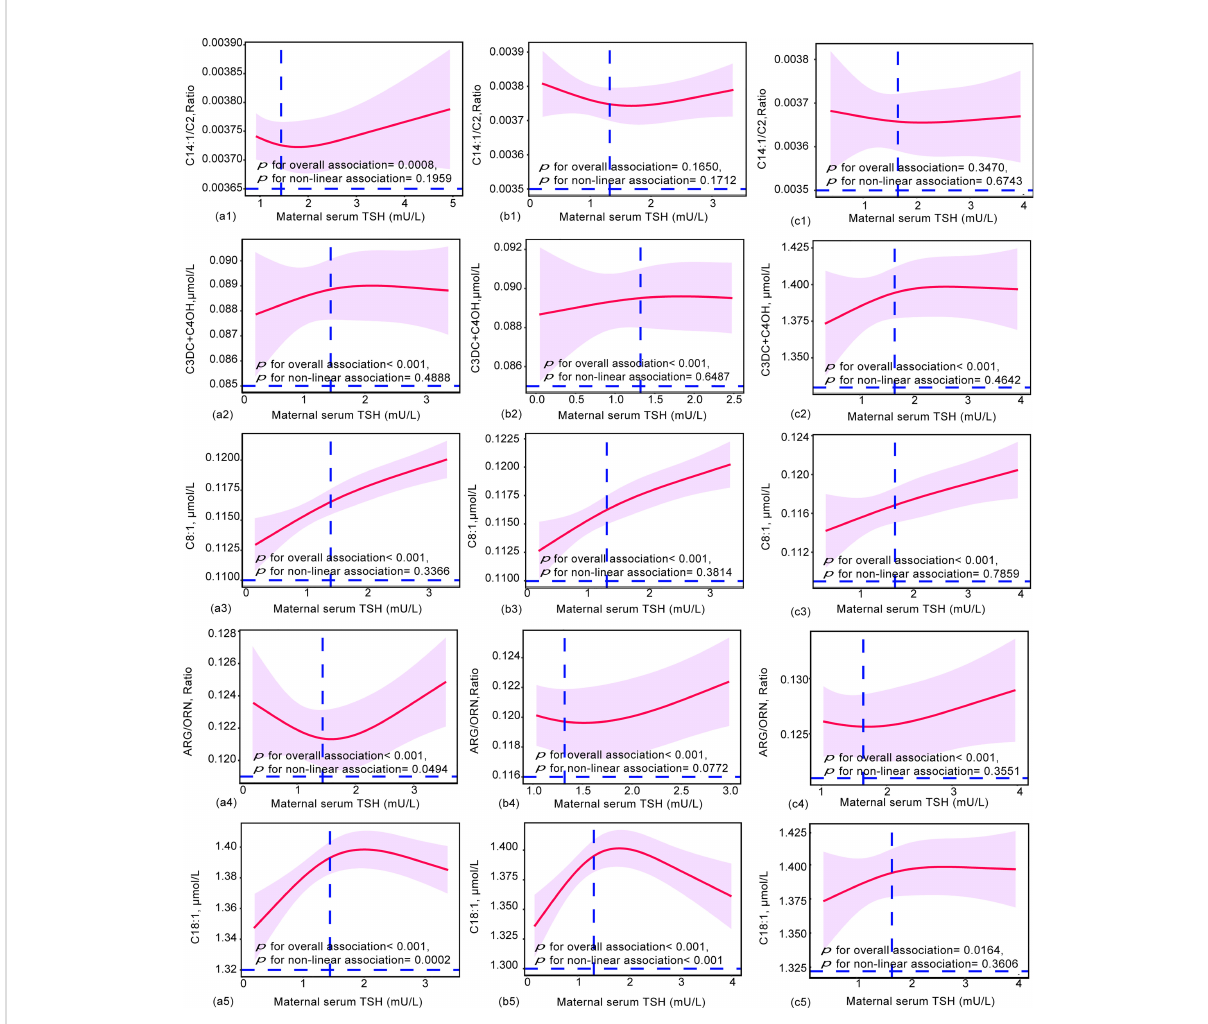
FIGURE 3 Restricted cubic spline (RCS) regression analysis for the maternal TSH and neonatal metabolites during (a) ( 1-5) overall pregnancy, (b) ( 1-5) at the fi rst trimester, or (c) (1-5) at the second and third trimesters. Neonatal metabolites included were selected by GLM models. The median concentrations of maternal TSH were 1.44 mU/L during overall pregnancy, 1.32 mU/L at the fi rst trimester and 1.65 mU/L at the second and third trimesters. RCS analysis was performed with adjustment by the age of pregnant women, gestational weeks, newborn birth weight and gestational age at